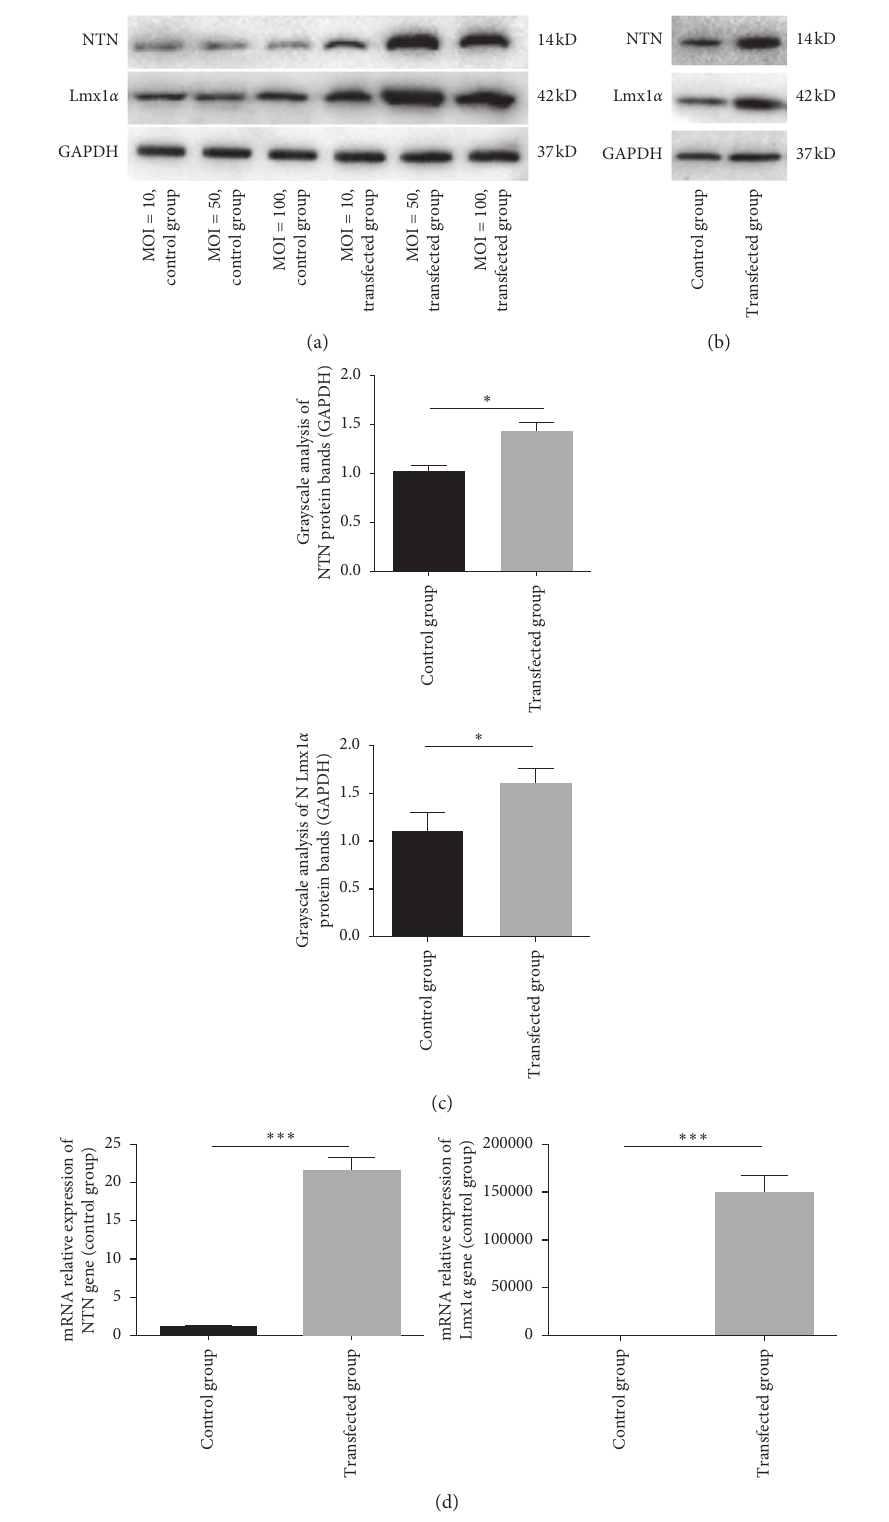
Figure 1: Gene transfection adopted by recombinant lentivirus to overexpress NTN and Lmx1 α . (a) Protein expression was the most abundant when MOI was 50. (b)–(d) Western blot analysis, grayscale analysis, and PCR analysis verified significantly high expression of NTN and Lmx1 α in the transfected group relative to the control group. GAPDH was used as an internal control. NTN, neurturin; Lmx1 α , LIM homeobox transcription factor 1 α ; GAPDH, glyceraldehyde-3-phosphate dehydrogenase; MOI, multiplicity of infection. ∗ P < 0 . 05. ∗∗∗ P < 0 .